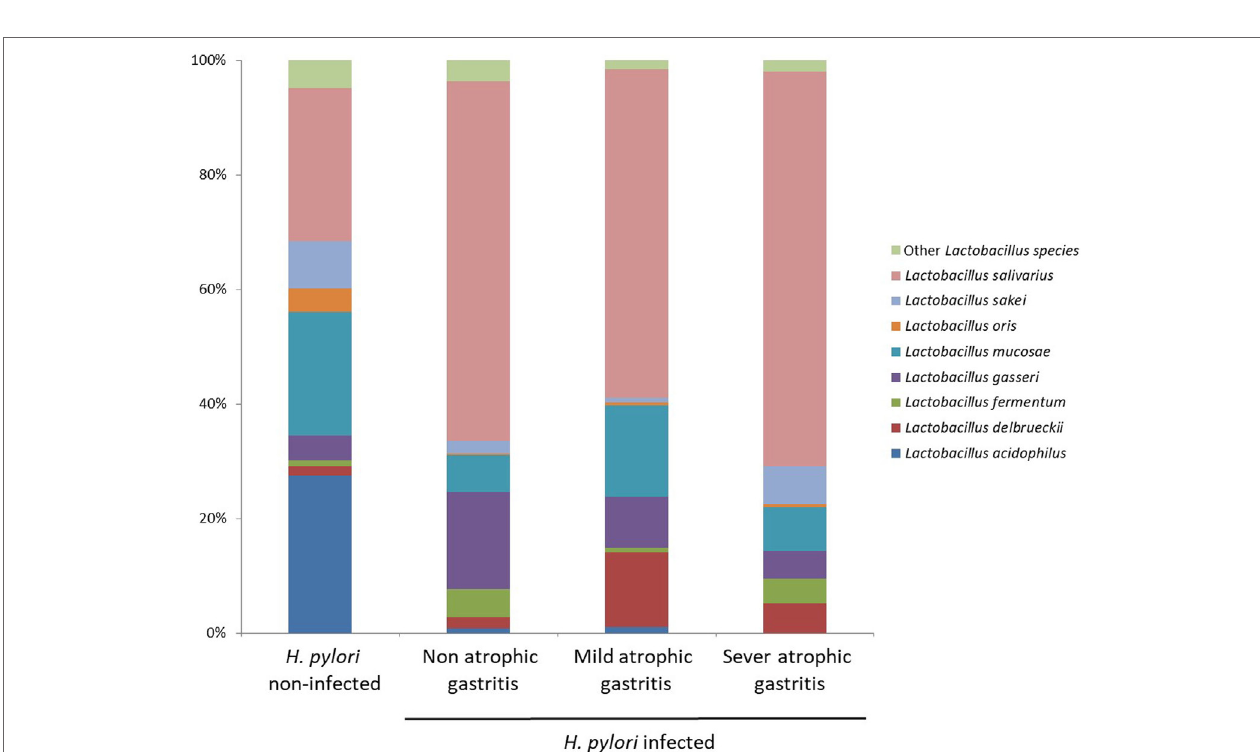
FigUre 4 | The relative abundance of the Lactobacillus in gut microbiota among the six age groups by decades.